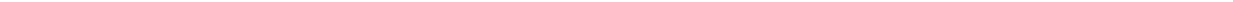
Fig. 1 Differentially expression of canonical TGF β /BMP-SMAD genes in ERG-de fi cient HUVEC. a Microarray analysis of ERG-dependent genes in HUVEC was performed at 24 and 48 h after ERG depletion, as described ( n = 3 biological replicates) 24 ; fold change (log 2) of selected TGF β /BMP associated genes represented as high (red) and low (blue) expression compared to the median (white). Gene expression data were validated in HUVEC transfected with Control (Con siRNA) or ERG siRNA by b quantitative PCR and c immunoblotting, showing reduction of ERG protein levels following siRNA, d quanti fi cation by fl uorescence intensity normalised to GAPDH for ERG, SMAD1, ENG, ID1, SMAD3, ALK5 and SMA ( n = 5). e Representative images of SMAD1 expression (white; arrows identify expression in the sinusoidal endothelium), VWF (green), SMA (red) and DAPI (blue) in liver tissue from Erg fl / fl and Erg cEC-het mice (Scale bar 50 μ m). f Quantitative analysis of TGF β 2 protein expression was performed by ELISA in whole cell HUVEC lysates ( n = 7). g Representative image of TGF β 2 expression in HUVEC transfected with control or ERG siRNA by immuno fl uorescence; nuclei are identi fi ed by DRAQ V and cells are co-stained for ERG (green). Scale bar 20 µ m. h Representative images of TGF β 2 expression (white; arrows) in large vessel within the liver from Erg fl / fl and Erg cEC-het mice (Scale bar 50 μ m). Data were normalised to GAPDH and compared to control siRNA treated (*) by unpaired t -test. All graphical data are mean ± s.e.m., * P < 0.05, ** P < 0.01, *** P <